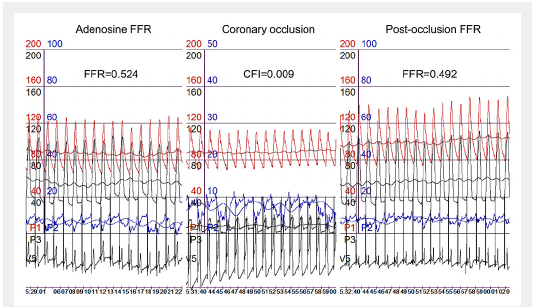
Simultaneous recordings of phasic and mean aortic (P ao for mean pressure in red), distal coronary (P d for mean pressure in black), occlusive coronary (P occl in black), and central venous pressure (CVP in blue), as well as an intracoronary ECG lead. During coronary occlusion, marked ECG ST-segment elevations are visible. CFI = collateral flow index; FFR = fractional flow